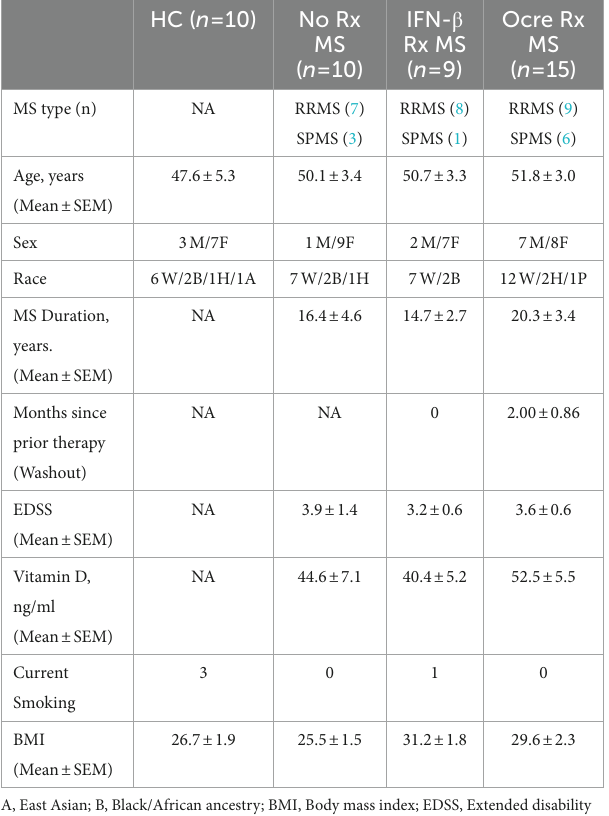
TABLE 1 Subject demographics and baseline